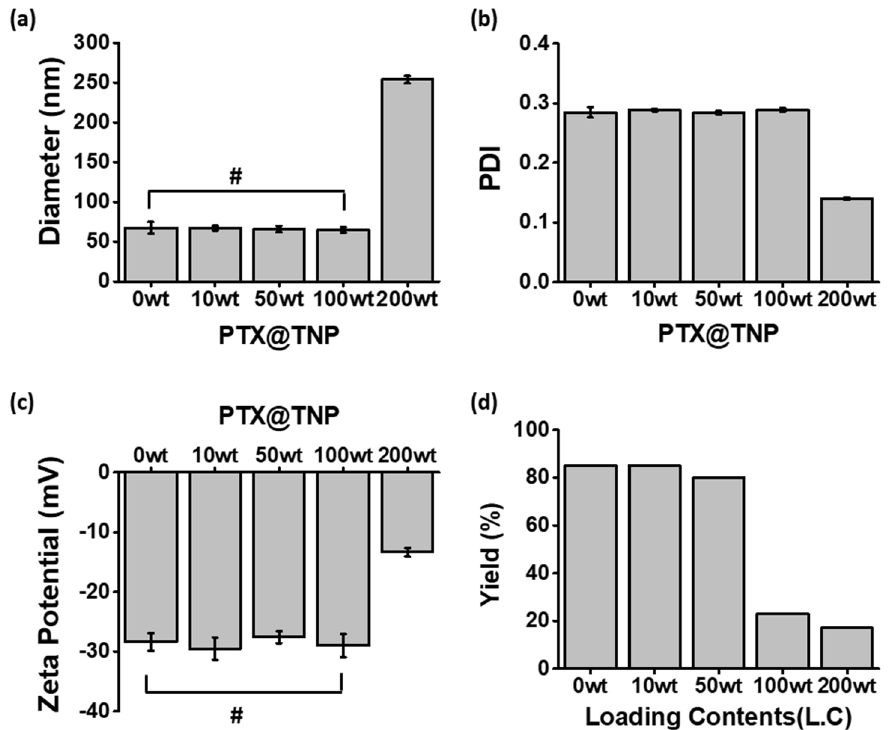
Figure 2. Physicochemical properties of PTX@TNPs with various loading contents, prepared via a single − solvent method using acetone. ( a ) Hydrodynamic diameter, ( b ) polydispersity index (PDI), ( c ) zeta potential, and ( d ) production yield ( n = 3). # p > 0.05.